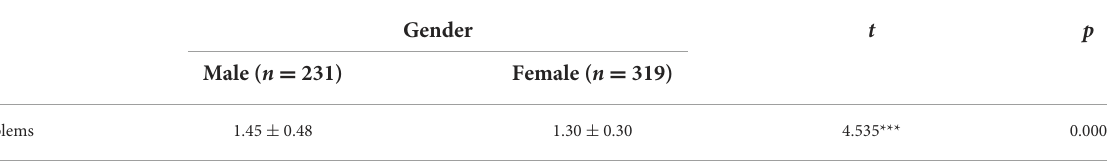
TABLE 1 t -test of immigrant adolescents’ conduct problems.